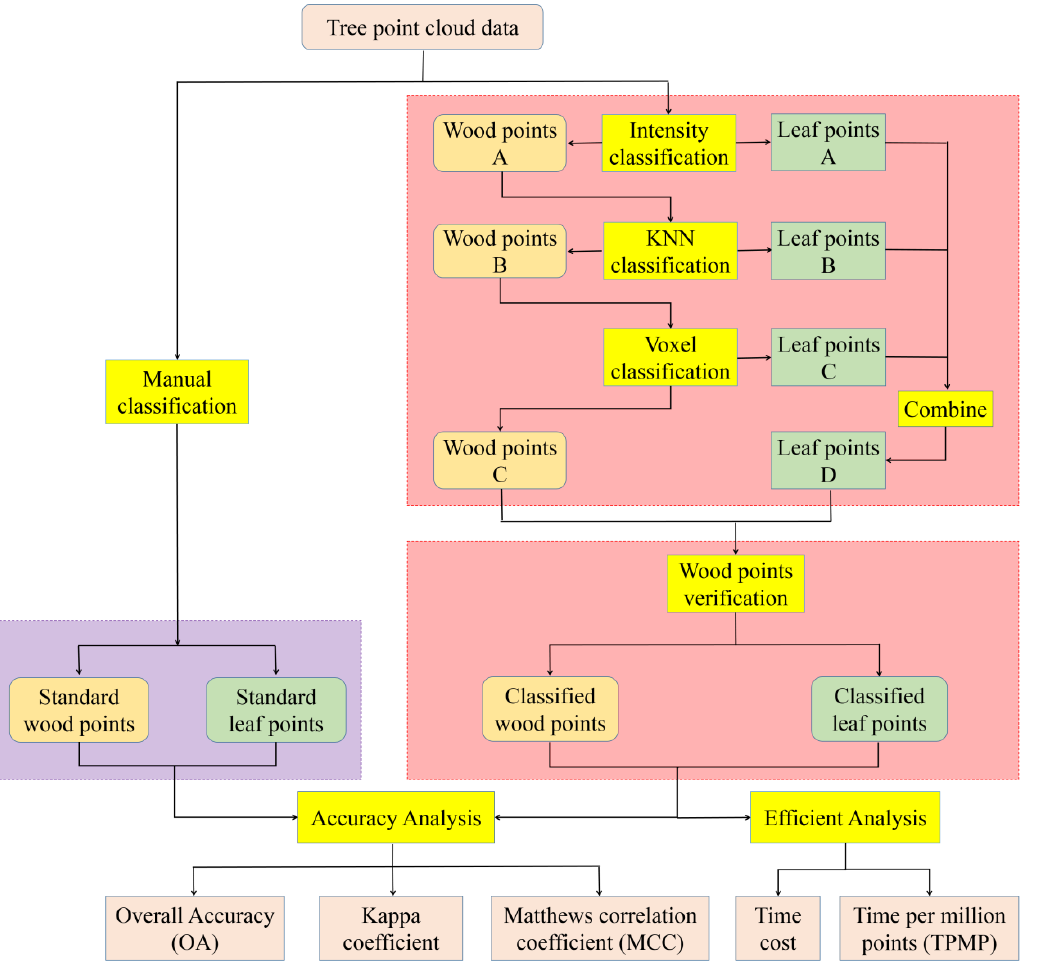
Figure 3. Flowchart of the proposed method.